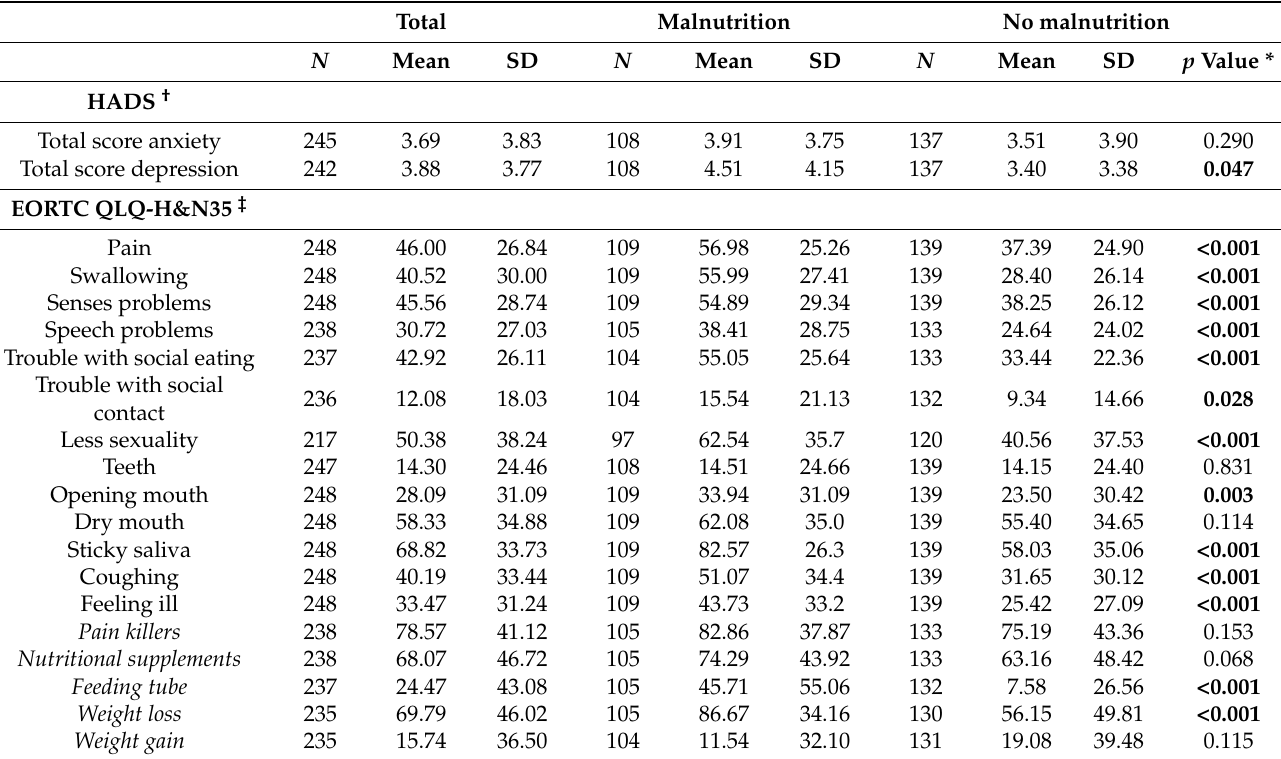
Table 2. Numbers (N), mean, and standard deviation (SD) on HADS and EORTC QLQ-H&N35 at seven weeks after the start of treatment for head and neck cancer regarding the total group, patients with malnutrition defined by the Global Leadership Initiative on Malnutrition (GLIM), and patients without malnutrition.